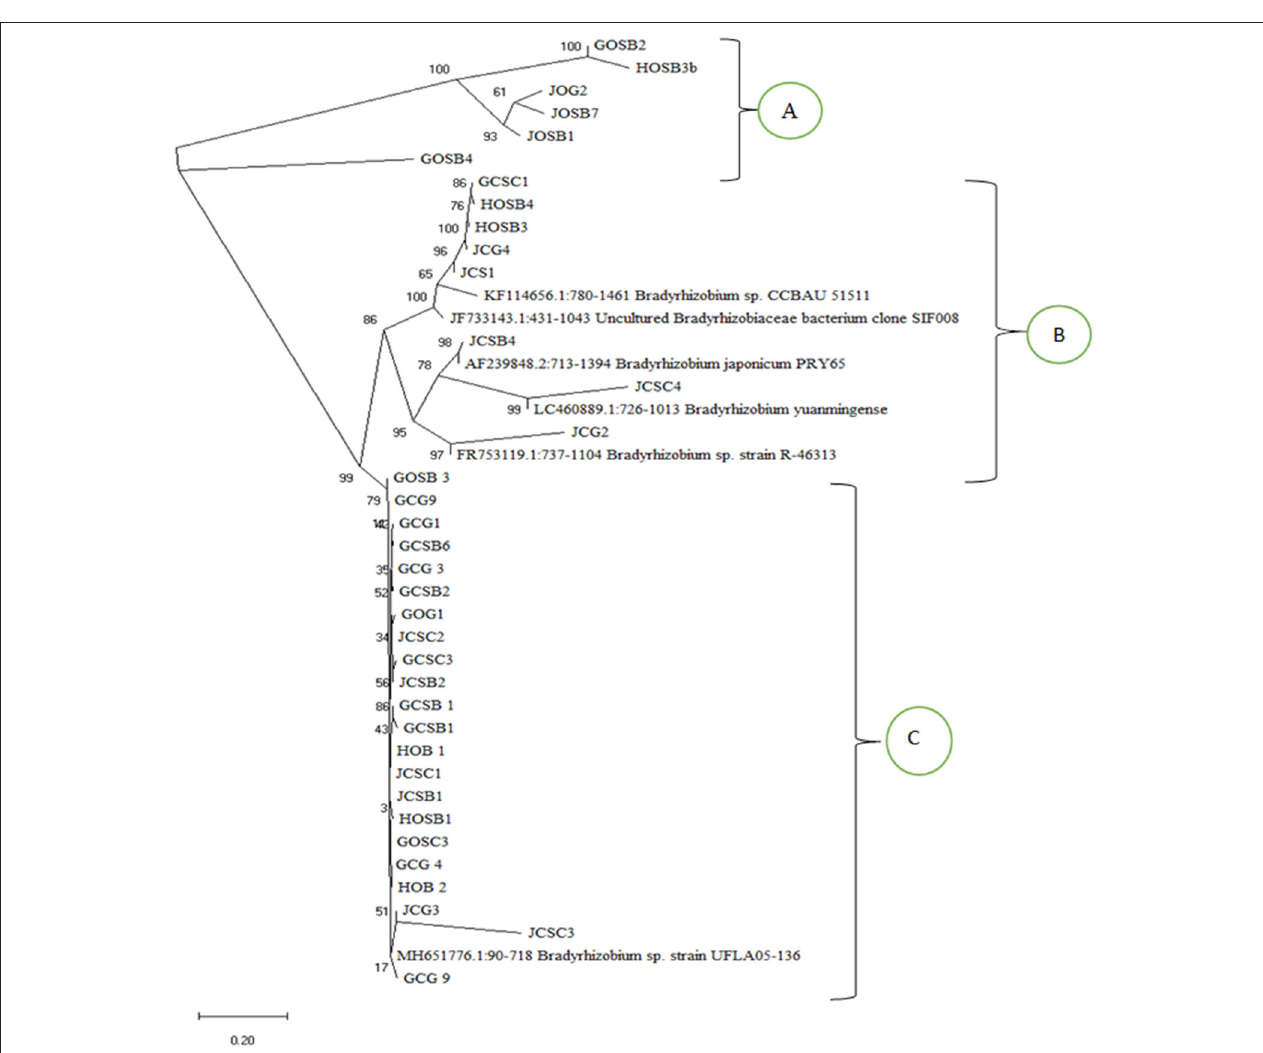
FIGURE 4 | Phylogenetic tree based on the partial 16S rDNA sequences using the Neighbor joining method (Saitou and Nei, 1987) showing the phylogenetic relationship of the nodule isolates and matching isolates from the NCBI database. The percentage of replicate trees in which the associated taxa clustered together in the bootstrap test (1,000 replicates) are shown next to the